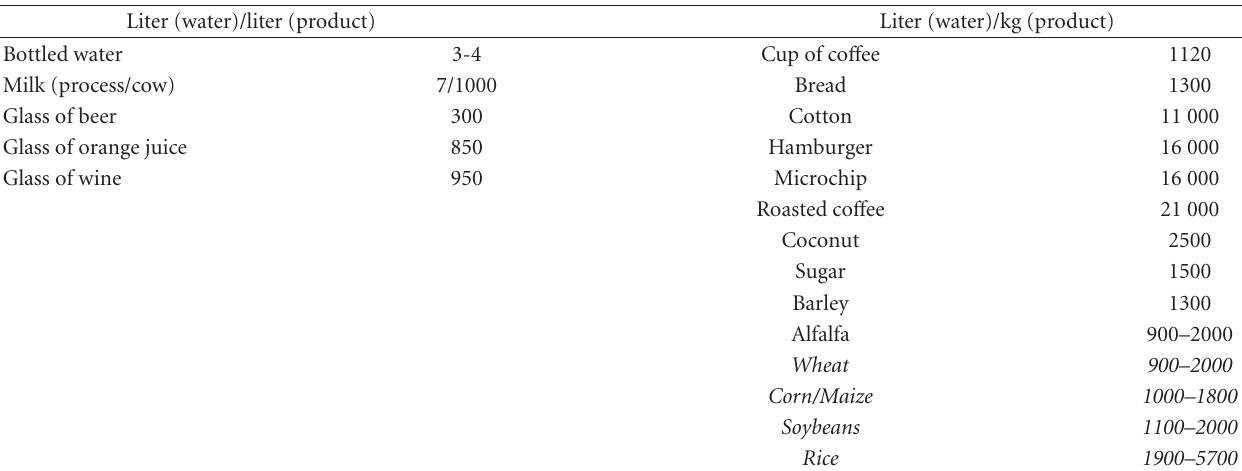
Table 2: Freshwater demand for selected staple and associated crops, goods, and beverages